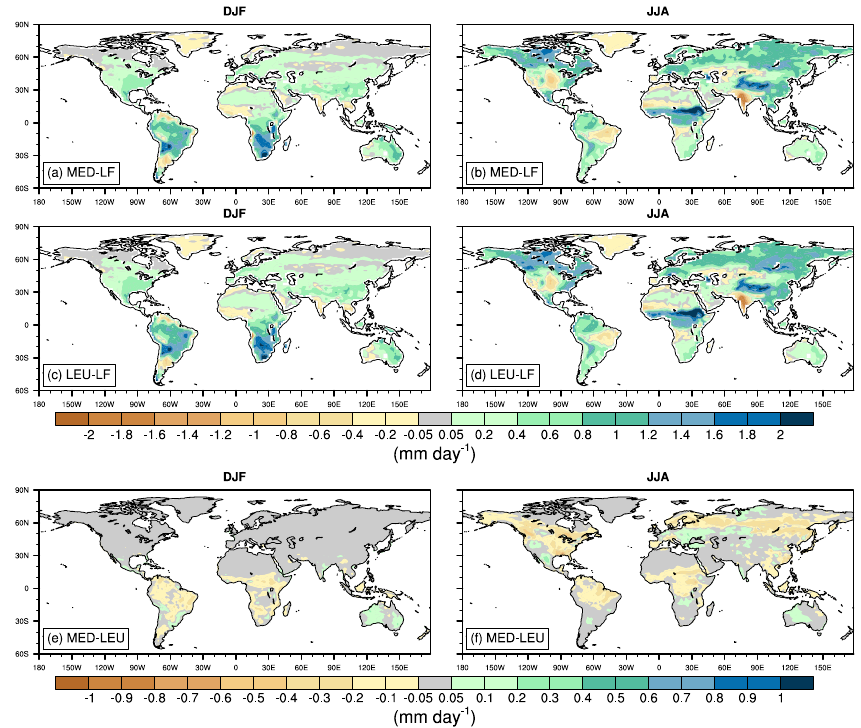
Figure 6. Same as in Fig. 2 except for evapotranspiration (ET). Multi-model estimates are from the LandFlux (LF) data set and seasonal means are computed over the period